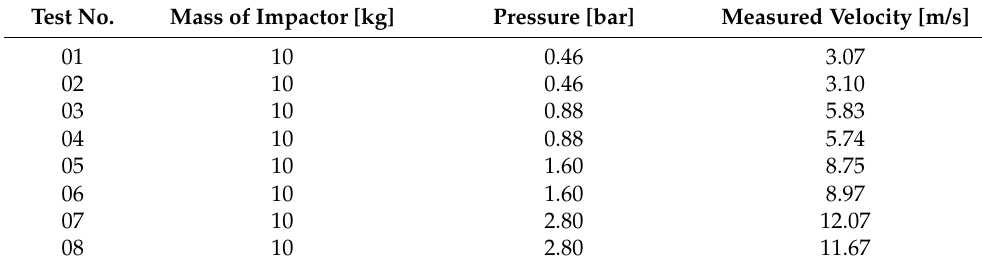
Table 1. Velocity test results.